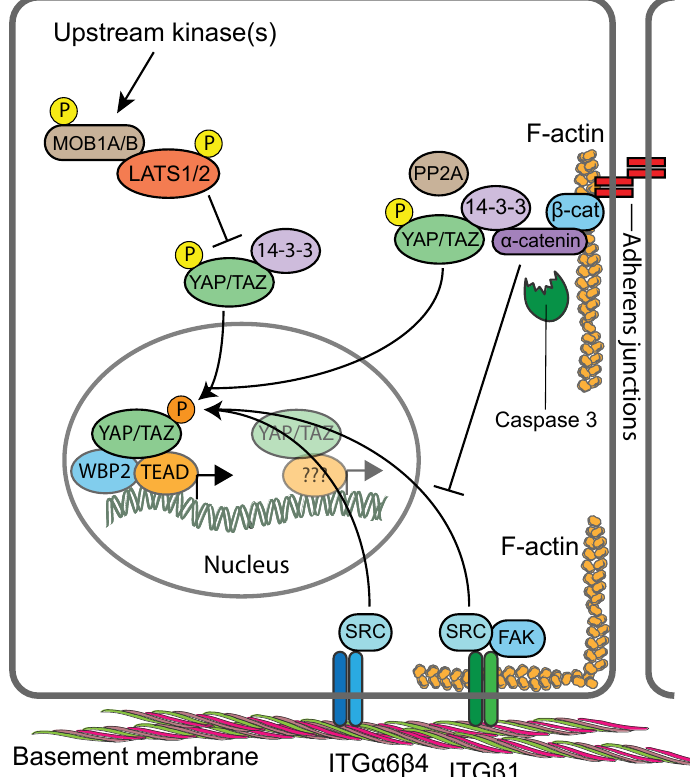
Figure 4. Regulation of YAP / TAZ in epidermal cells. Hippo signalling via MOB1A / MOB1B and LATS1 / LATS2 inhibits YAP / TAZ via serine phosphorylation (yellow) to promote cytoplasmic retention. The kinases activating MOB1A / MOB1B and LATS1 / LATS2 are not known. Integrin (ITG)–SRC signalling promotes YAP / TAZ nuclear localisation and TEAD binding. SRC can directly phosphorylate YAP / TAZ on tyrosine residues (orange) but may also act indirectly to activate Hippo signalling. A contractile F-actin-myosin cytoskeleton helps stabilise ITG β 1 adhesions and thus may contribute to SRC activation, whileITG β 4adhesionsarepartofhemidesmosomalcomplexesthatarestabilisedbykeratinintermediate filaments (not shown). At adherens junctions, α -catenin controls YAP / TAZ activity and phosphorylation by modulating its interaction with 14-3-3 and the PP2A phosphatase. In proliferating cells of the sebaceous gland, activation of caspase-3 cleaves α -catenin, thus facilitating the activation and nuclear translocation of YAP / TAZ. α -catenin can also inhibit ITG β 4-mediated direct activation of SRC. Putative nuclear interactions of YAP / TAZ with other transcription factors are also